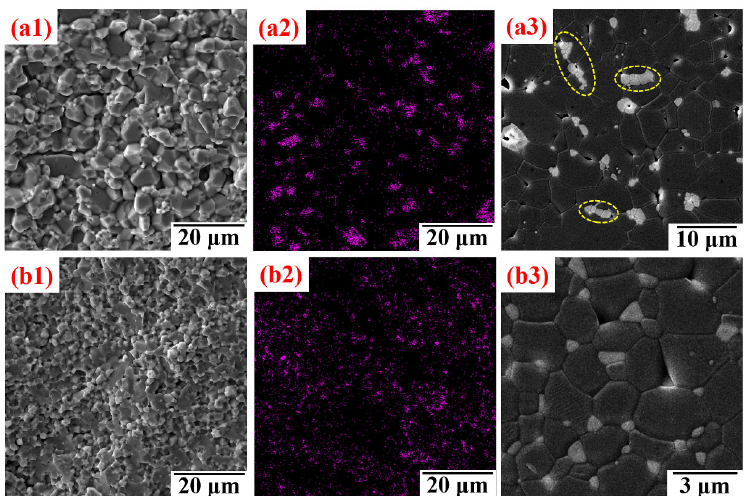
Fig. 13 SEM images and corresponding EDS mappings for Y on the fracture surfaces of (a1, a2) Sample MM and (b1, b2) Sample CP; SEM micrographs of the polished and etched surfaces of (a3) Sample MM and (b3) Sample CP. The semi-connected second phases are marked with yellow circles.